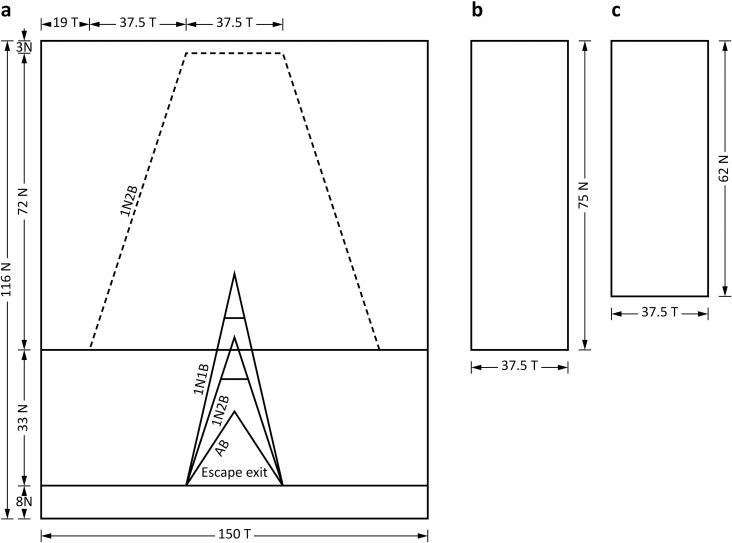
Plans of the (a) extension cylinder (showing the AB-, 1N2B- and 1N1B-exit openings) and (b) 75-N and (c) 62-N guiding panels. T, transversals; N, normal.